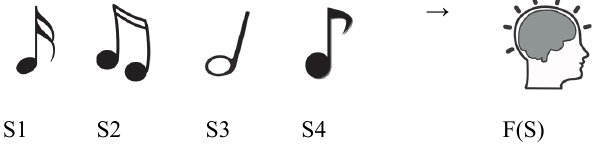
Fig. 1. Harmony vector representation with musical